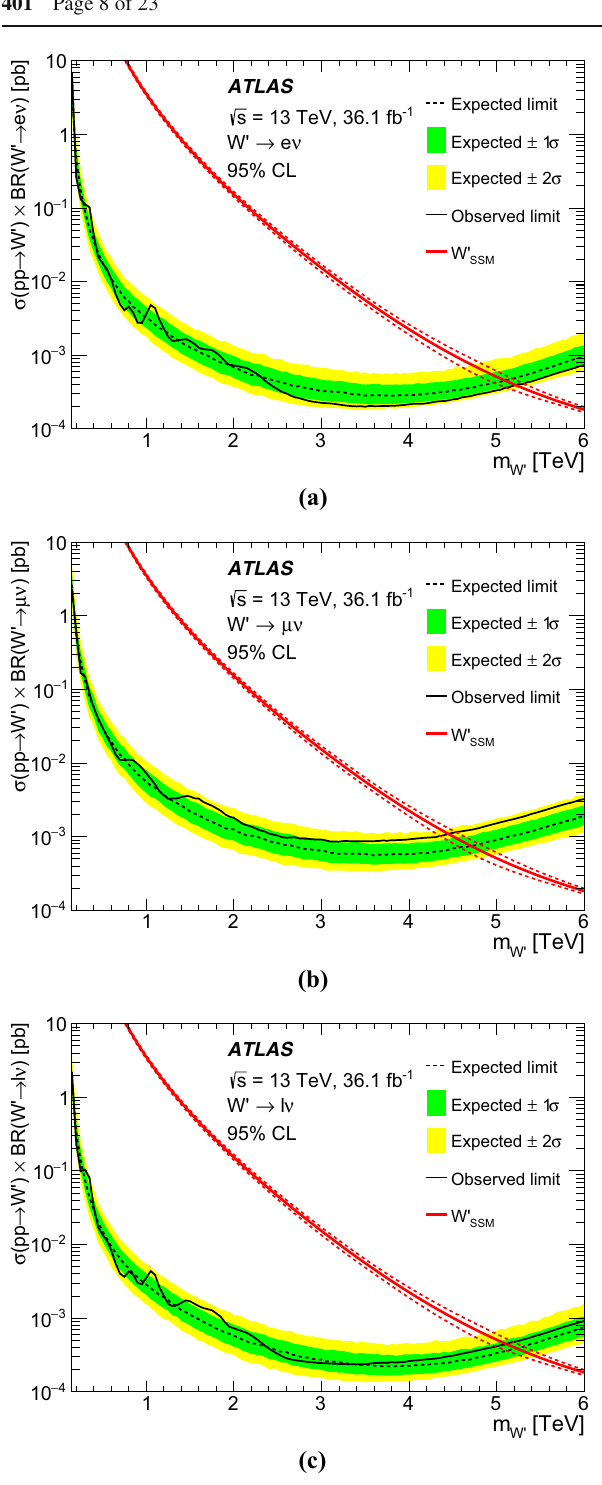
Fig. 2 Observed (solid black line) and expected (dashed black line) upper limits on cross-section times branching ratio ( σ × BR ) as a func- tionoftheSSM W (cid:2) bosonmassinthe a electron, b muonand c combined electron and muon channels. The 1 σ (green) and 2 σ (yellow) expected limit bands are also shown. The predicted σ × BR for SSM W (cid:2) pro- duction is shown as a red solid line. For illustration the uncertainties in σ × BR from the PDF, α s and the renormalisation and factorisation scales are also shown as red-dashed lines